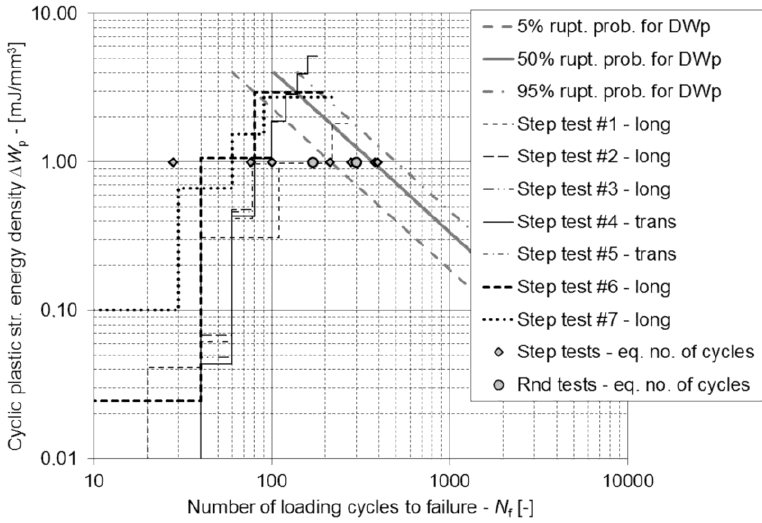
Figure 11. Fatigue-life curves with the variable-amplitude loading results for the plastic strain-energy density ∆ W p (DWp); ∆ W p,eq = 1 mJ / mm 3 .